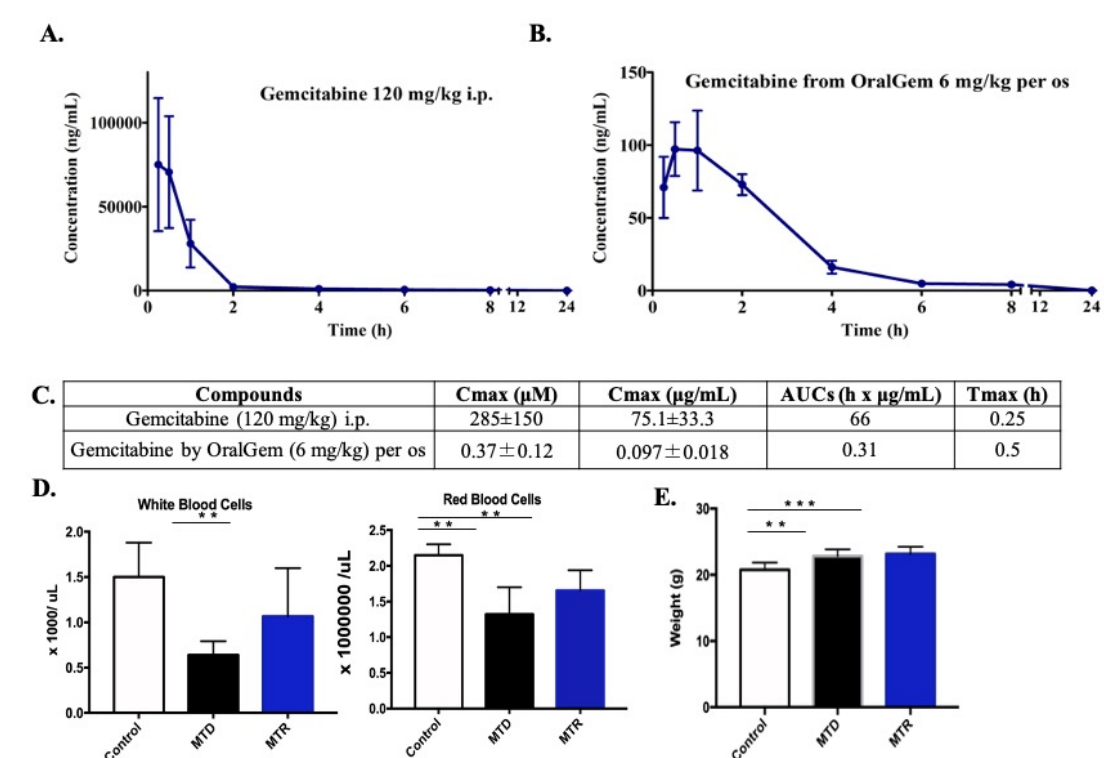
Figure 1. Pharmacokinetic and toxicity analysis of metronomic (MTR) OralGem treatment. ( A ) Gemcitabine was administered i.p. at the high dose of 120 mg/kg in C57BL/6 mice, reaching the concentration of 285 µ M in circulating blood ( n = 6, set of experiments = 1). ( B ) OralGem was administered orally once at a dose of 6 mg/kg in C57BL/6 mice, leading to the generation of gemcitabine in the bloodstream at a maximum concentration of 0.4 µ M ( n = 6, set of experiments = 1). ( C ) Table showing the C max , Area Under the Curve (AUCs) and T max of each compound. ( D ) C57BL/6 wild-type mice were used and divided into 3 main groups. In the maximum tolerated dose (MTD) group, mice ( n = 5) were administered intraperitoneally a dose of 120 mg/kg 8 times in a period of 21 days, whereas, in the MTR group, animals ( n = 6) were administered orally the low dose of 6 mg/kg of OralGem every day for 21 days. Finally, the control group ( n = 5) received orally 21 times carboxymethyl cellulose (CMC) 0.5% (set of experiments = 1). When the protocol was completed, mice were sacrificed, and whole blood was collected and analyzed to detect any alteration of white (WBCs) and red blood cells (RBCs). Numbers of WBCs and RBCs in both types of treatment (MTR n = 6, MTD n = 5) compared to the control group ( n = 5). ( E ) Average weight (g) of animals. Data represent mean ± SD. Statistical analysis was performed by Student’s t -test; ** p < 0.01 and *** p <